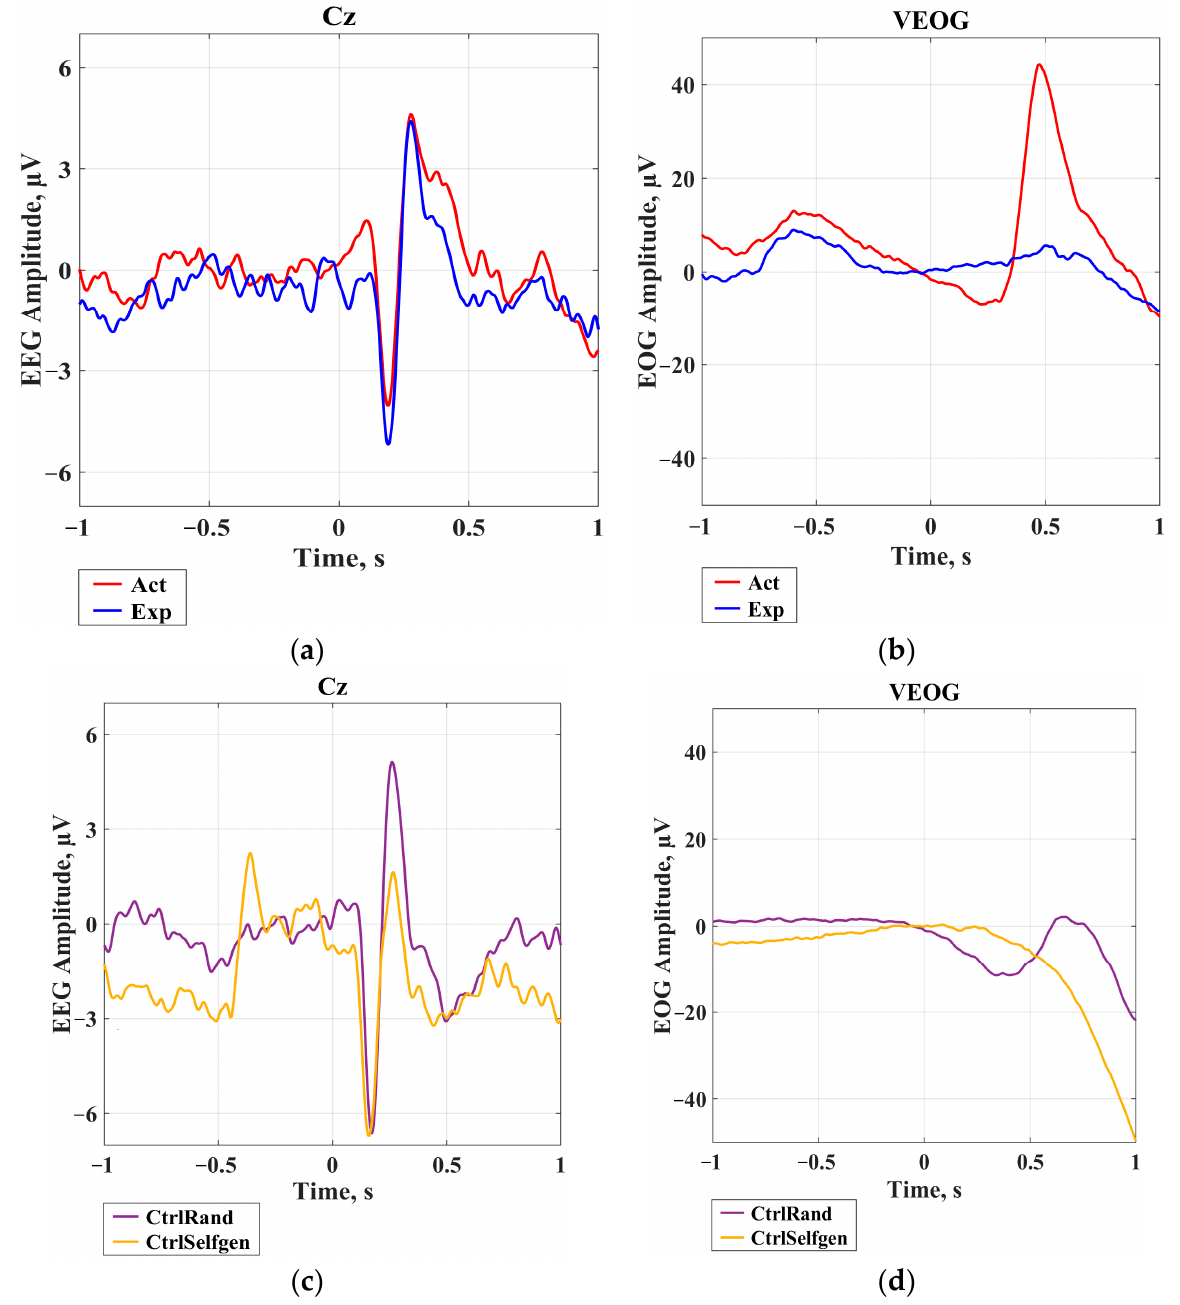
Figure 4. ( a , c ): Grand average auditory ERP in Cz to the sound, ( a ): for main conditions, ( c ): for control conditions. ( b , d ): Vertical EOG, ( b ): for main conditions, ( d ): for control conditions (0 s corresponds to the beginning of the sound).